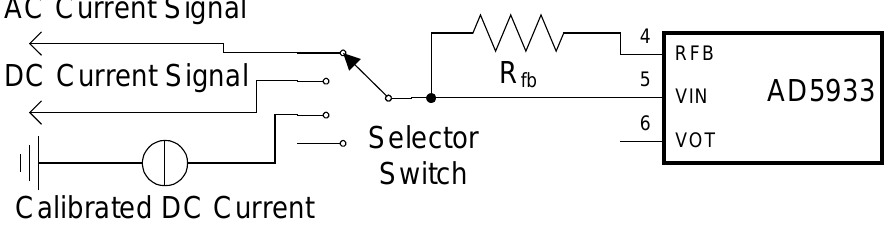
Figure 9. Simplified schematic for AD5933 calibration, DC and AC measurements: internal DC offset is processed by the on-chip circuitry and recorded when the selector switch is at the bottom, system DC gain is measured when the switch is connected to a calibrated DC current source. The same system measures AC current when the selector switch is in top